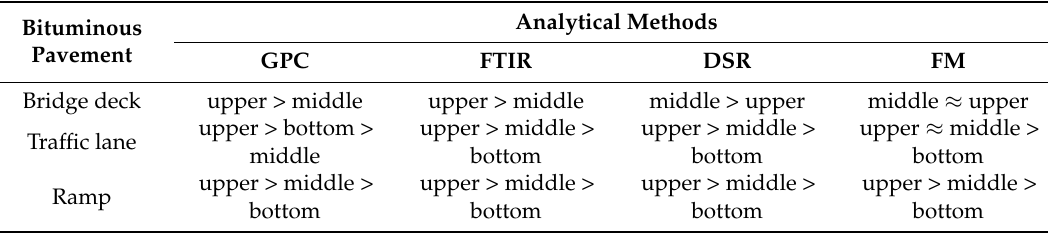
Table 2. Aging degree sequences of bitumen with different analytical